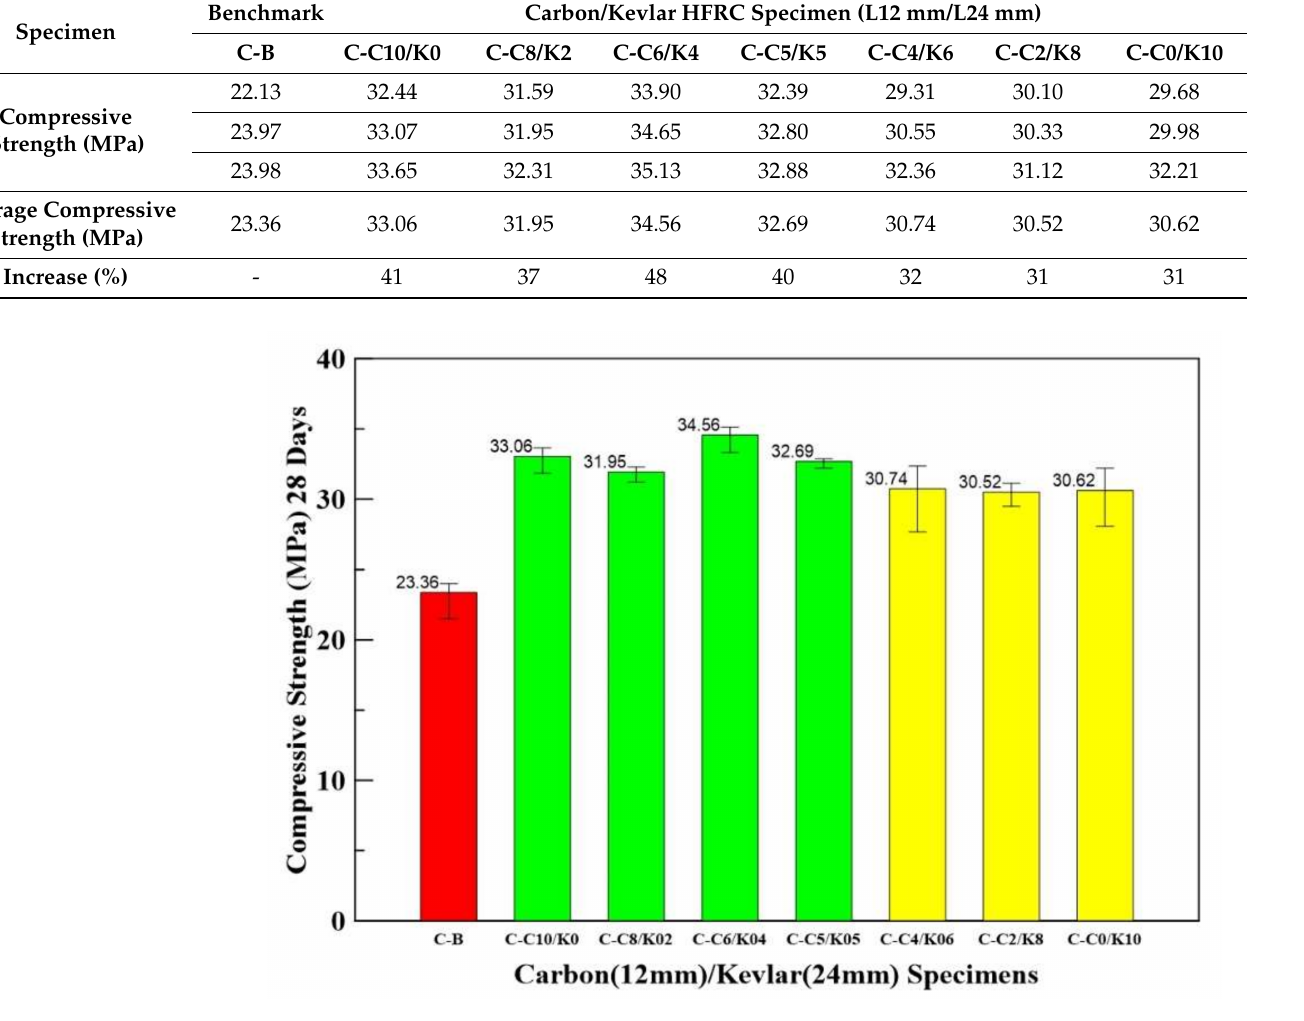
Figure 7. Bar chart for compressive strengths of benchmark and carbon/Kevlar HFRC